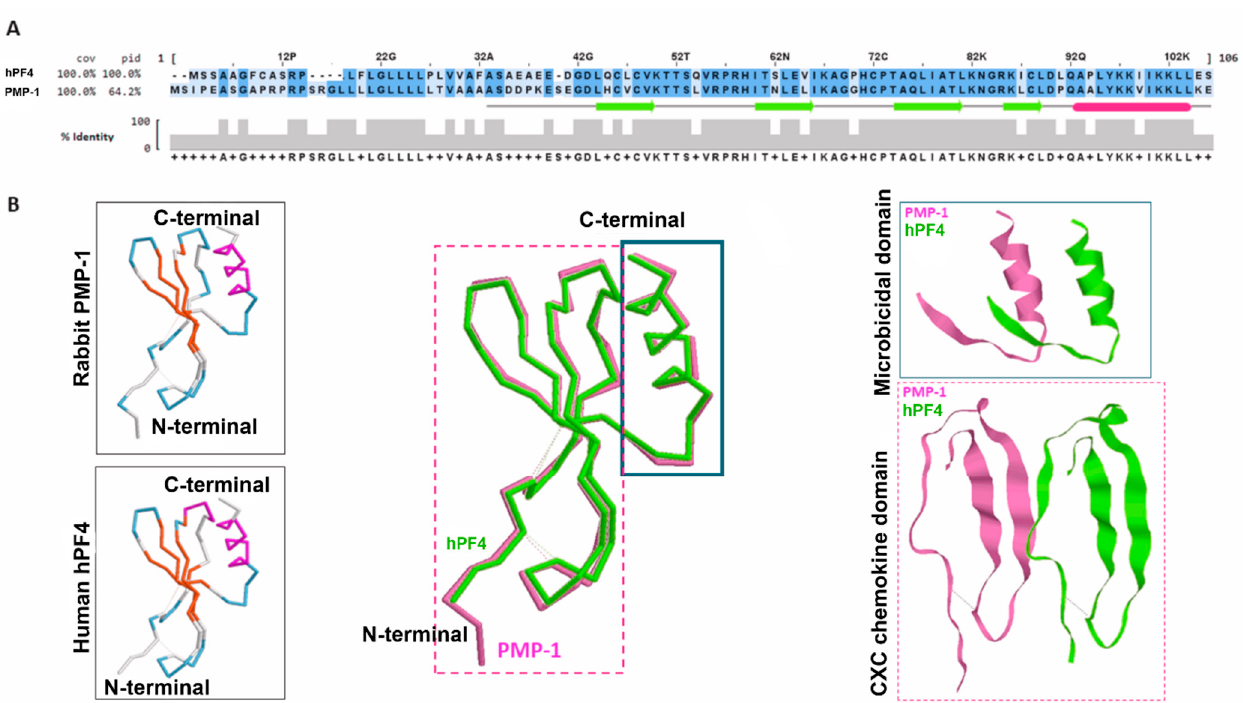
Figure 2. Comparative analysis of PMP-1 and human hPF4. ( A ) Comparative alignment of the primary structure of PMP-1 (rabbit) and hPF4 (human) generated with Clustal Omega and visualized with Jalview and Mview. hPF4 sequence was employed as a template. The total coverage percentage and identity are depicted on the left side. The predicted structure for PMP-1 with JPred of Jalview is indicated in the middle. The green arrows and red segment indicate the β -sheets and α -helices, respectively. The identity per base is represented in the gray scheme by the color intensity. ( B ) Left side, predicted structure for each protein obtained with SWISS-MODEL and visualized in RasMol in colors according to their structures. Both overlapping structures are visible in the center; the microbicidal domain is indicated in the solid blue line box and the chemokine domain in the dotted red line box. A dotted line indicates disulfide bonds. The human hPF4 is colored in green and PMP-1 of rabbit in pink. On the right side, a zoom of each domain. The chemokine domain was rotated to the right for more precise visualization of this structure.